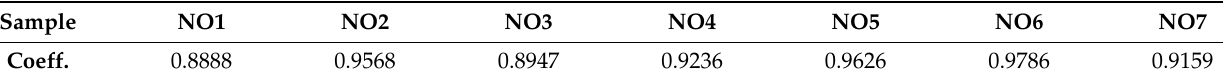
Table 4. Area-to-perimeter ratio results.